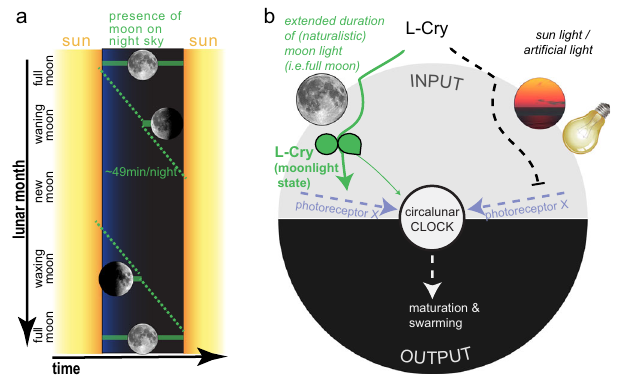
Fig. 7 | The entrainment of the monthly oscillator requires the detection of a speci fi c moon phase. a Representation of the presence of the moon on the sky depending on moon phase. As a full cycle of the moon around the earth takes on average 24.8 h the presence of the moon relative to the sun shifts every night by ~49min,indicatedbythegreendiagonal.Wormsneedtospeci fi callydetectthefull moon phase for circalunar oscillator entrainment, which requires that they can realize when a speci fi c light (moonlight) starts and ends 26 . b L-Cry ’ s function as moonlightdurationandintensitydetectorforcircalunarclockentrainment.L-Cry ’ s biochemicalpropertytoonlyreachthefullmoonlightstateafterextendedperiods of (naturalistic) moonlight illumination allows for a discrimination of moonlight duration. As moon phases are characterized by the duration (and intensity) of the moon on the night sky, moonlight exposure duration translates into moon phase detection. When L-Cry is in its moonlight state it permits (thick green arrow) ef fi - cient entrainment of the circalunar oscillator via a yet unidenti fi ed photoreceptor X,whileL-Cry(partly)blocks(dottedline)thelightforcircalunarentrainmentwhen it is in its sunlight state. L-Cry might also provide minor information as entraining photoreceptor to the circalunar oscillator (thin green